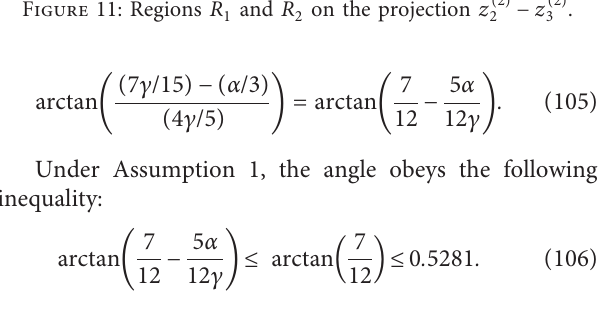
and R on the projection z ( 2 ) 1 2